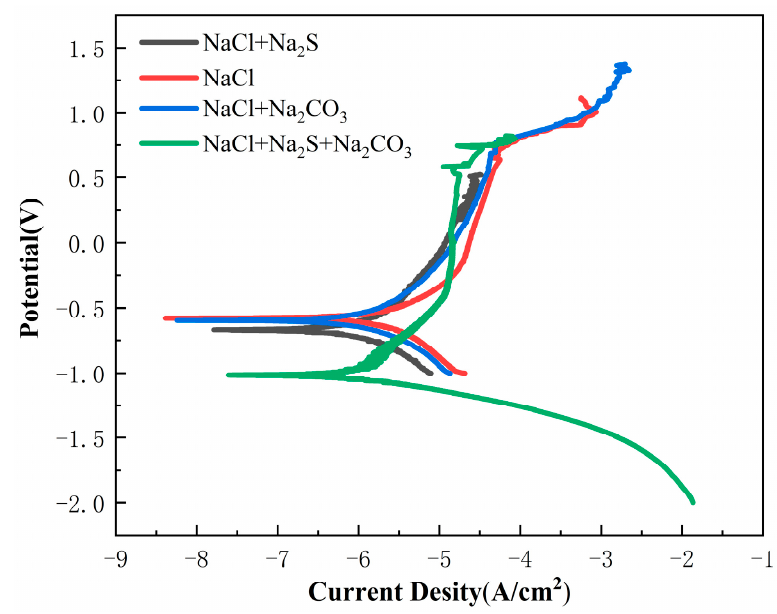
Figure 8. Polarization curves of TC4 titanium alloy under four corrosion environments. Table 7. Electrochemical parameters of TC4 titanium alloy in various corrosion environments.